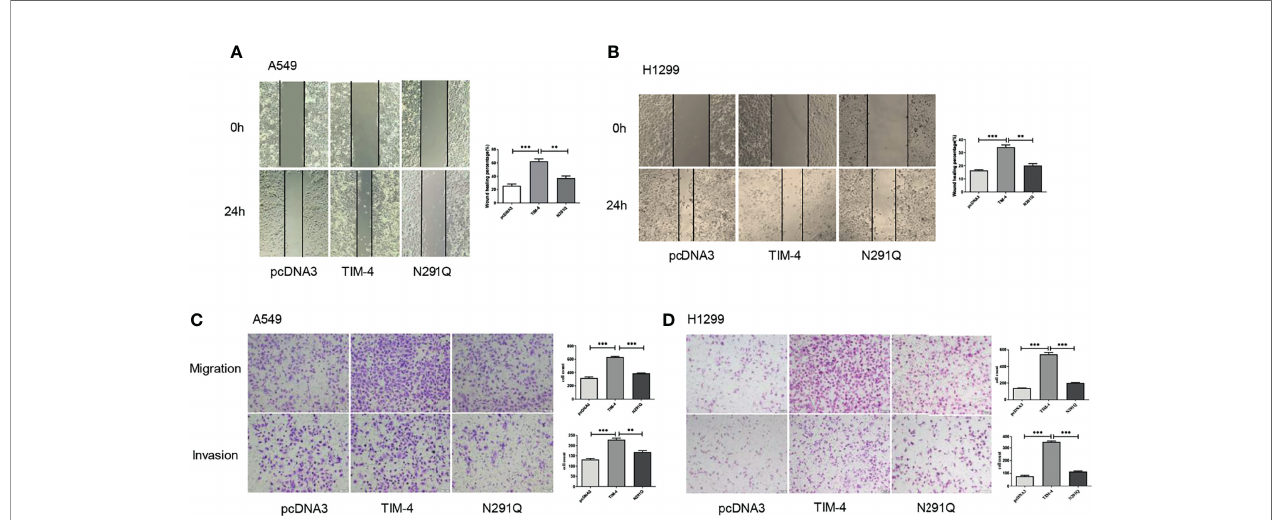
FIGURE 3 | N-glycosylated TIM-4 promotes metastasis of NSCLC cells. Wound healing assay was performed to evaluate the migration abilities of TIM-4-transfected and N291Q-transfected A549 cells (A) and H1299 cells (B) . Transwell assay was performed to evaluate the migration and invasive abilities of TIM-4-transfected and N291Q-transfected A549 cells (C) and H1299 cells (D) . (Scale bar:100 m m) All error bars were shown as mean ± SD of three independent experiments. **p < 0.01, ***p < 0.001, by Student ’ s t-test.